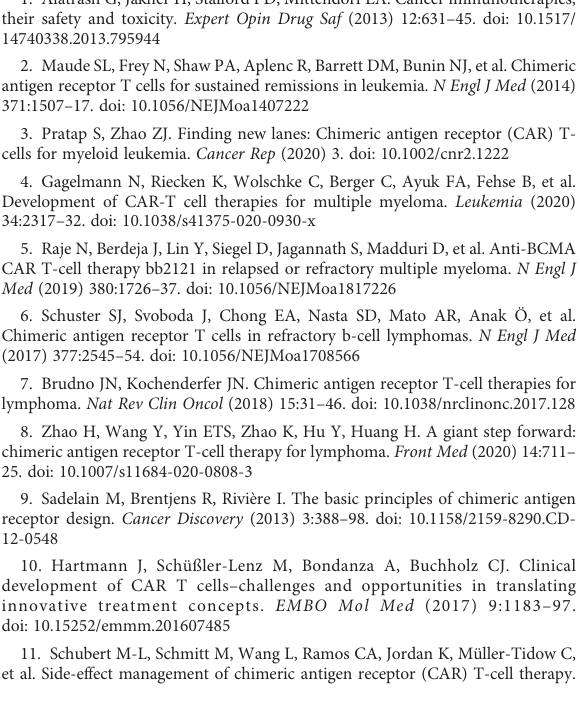
SUPPLEMENTARY FIGURE 3 Illustration of the PAT fl ow algorithm. SUPPLEMENTARY FIGURE 4 Proportion of CAR-positive cells in each of the participants with increasing ICANS grade. SUPPLEMENTARY FIGURE 5 Flow chart of the CAR-T single cell data portraying work fl ow. SUPPLEMENTARY FIGURE 6 CD4 and CAR expression characteristics in CD3+ T cells.